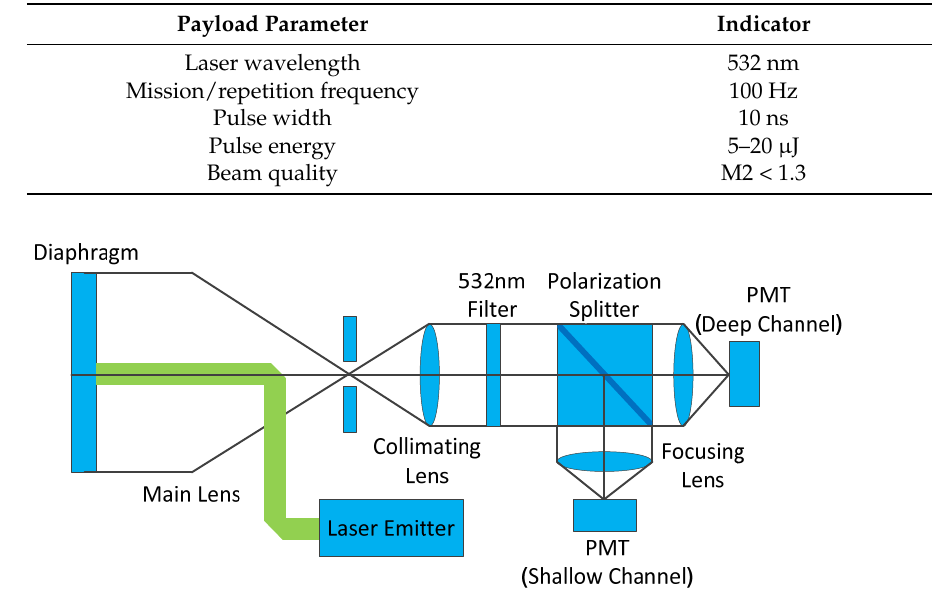
Figure 7. Diagram of the optical path structure of